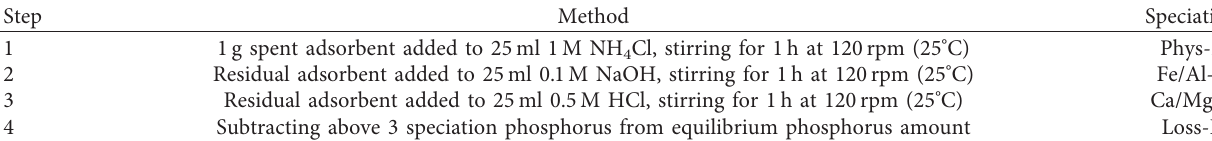
Table 2: Extraction procedure for different speciation of phosphorus.